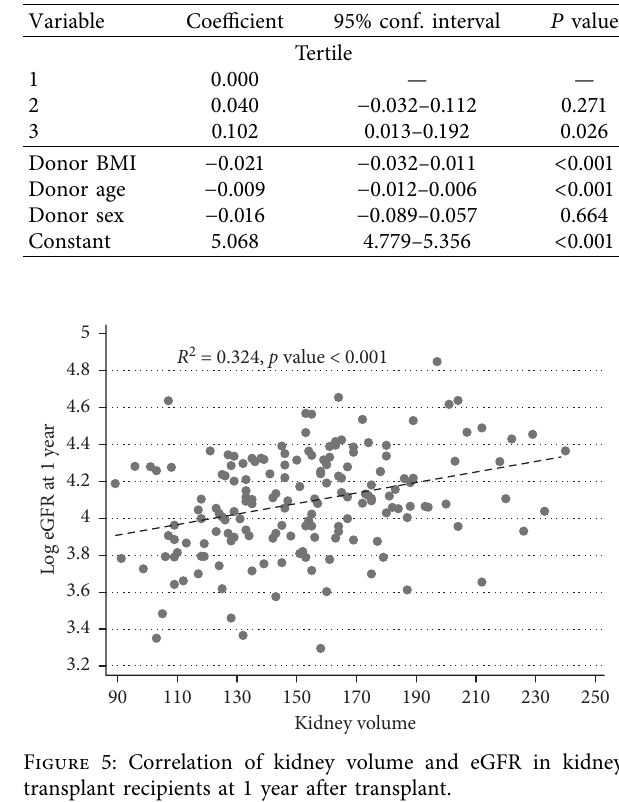
Table 2: Multivariable model for the effect of donor volume tertiles